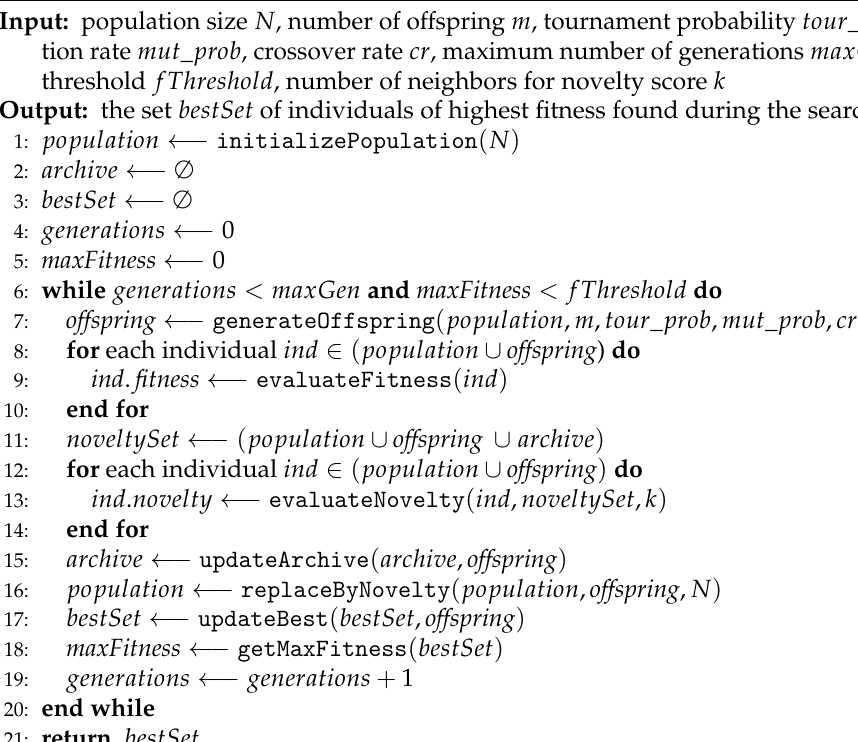
Algorithm 1 Novelty-based Genetic Algorithm with Multiple